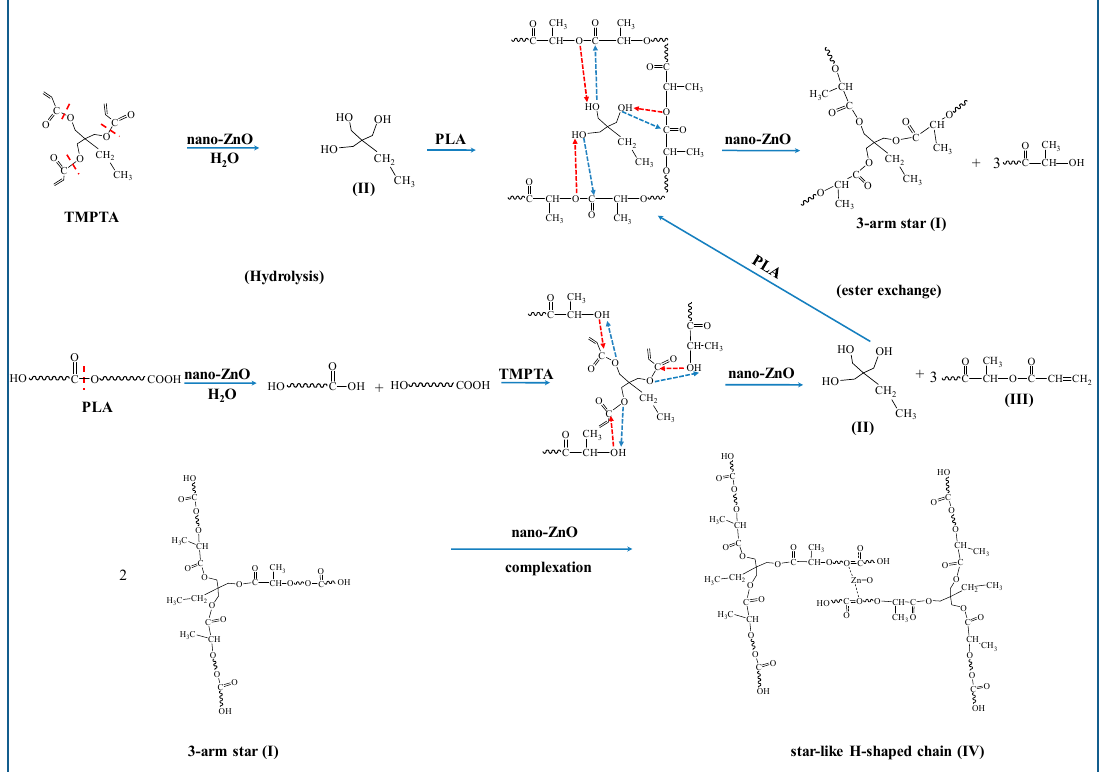
Figure 6. The proposed reaction mechanism for the exchange reaction of PLA with TMPTA accelerated by nano-ZnO.